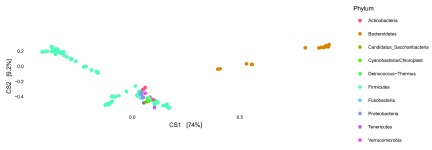
The DPCoA sample positions can be interpreted with respect to the species coordinates in this display.